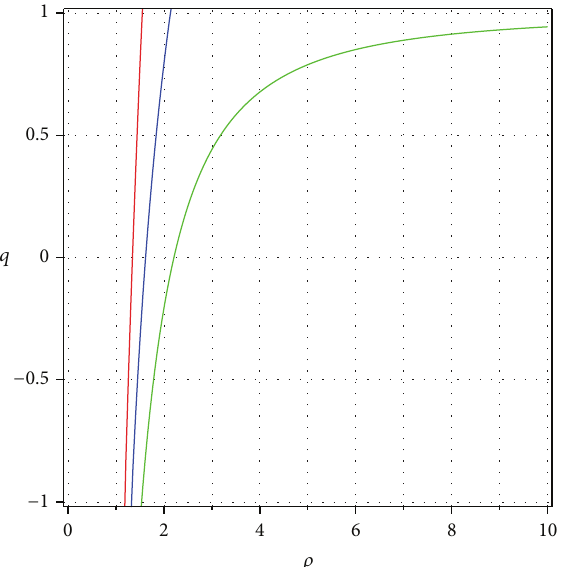
Figure 10: Deceleration parameter versus density for 𝐵 = 3 , 𝛼 = 0.9 , and 𝐴 = 1/3 . 𝑛 = 1 (green line), 𝑛 = 2 (blue line), 𝑛 = 3 (red line).